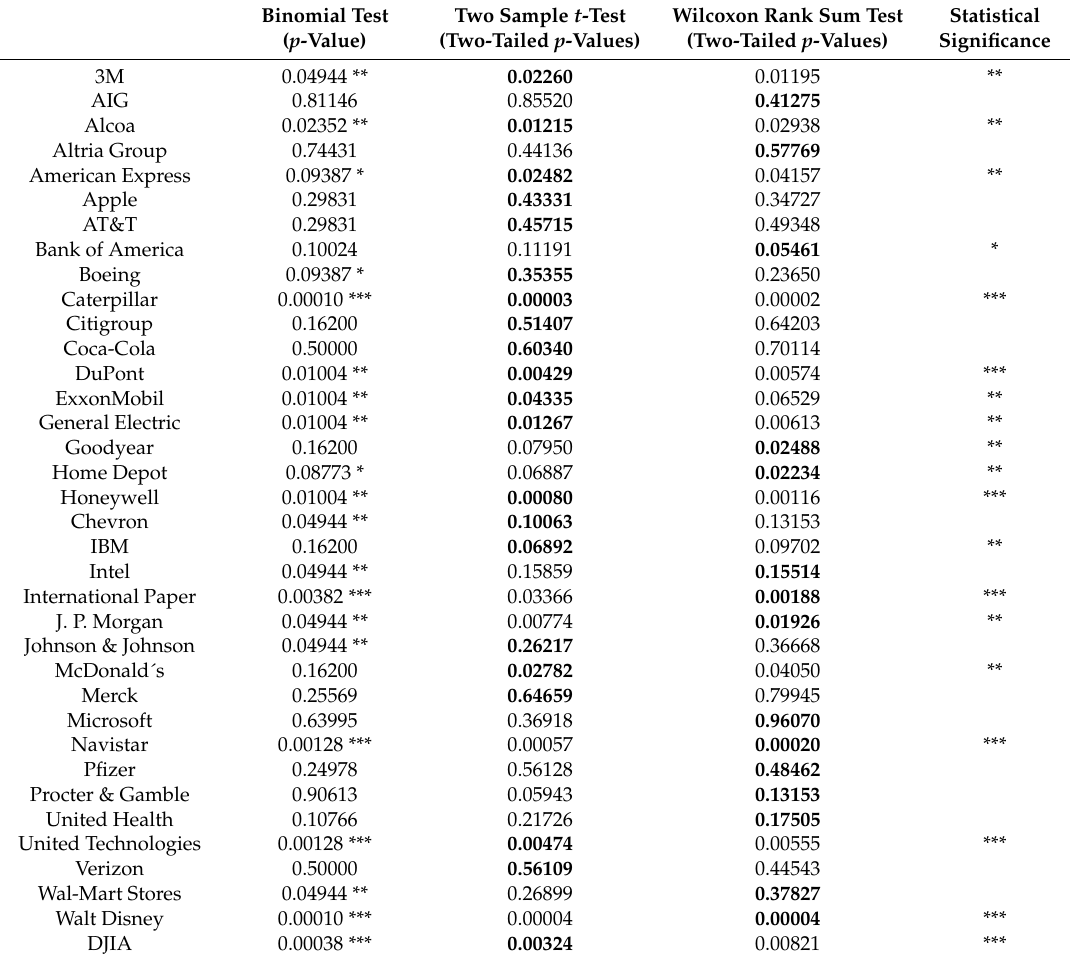
Table 3. Statistical significance